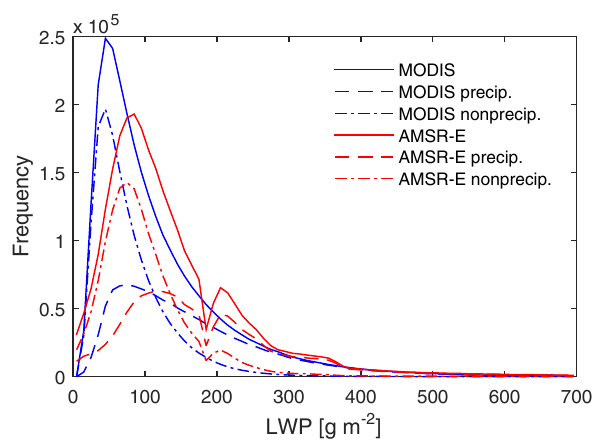
Figure 6. Distribution of frequency of LWP derived from MODIS and AMSR-E under different scenarios, namely, all samples, non- precipitation and only-precipitation